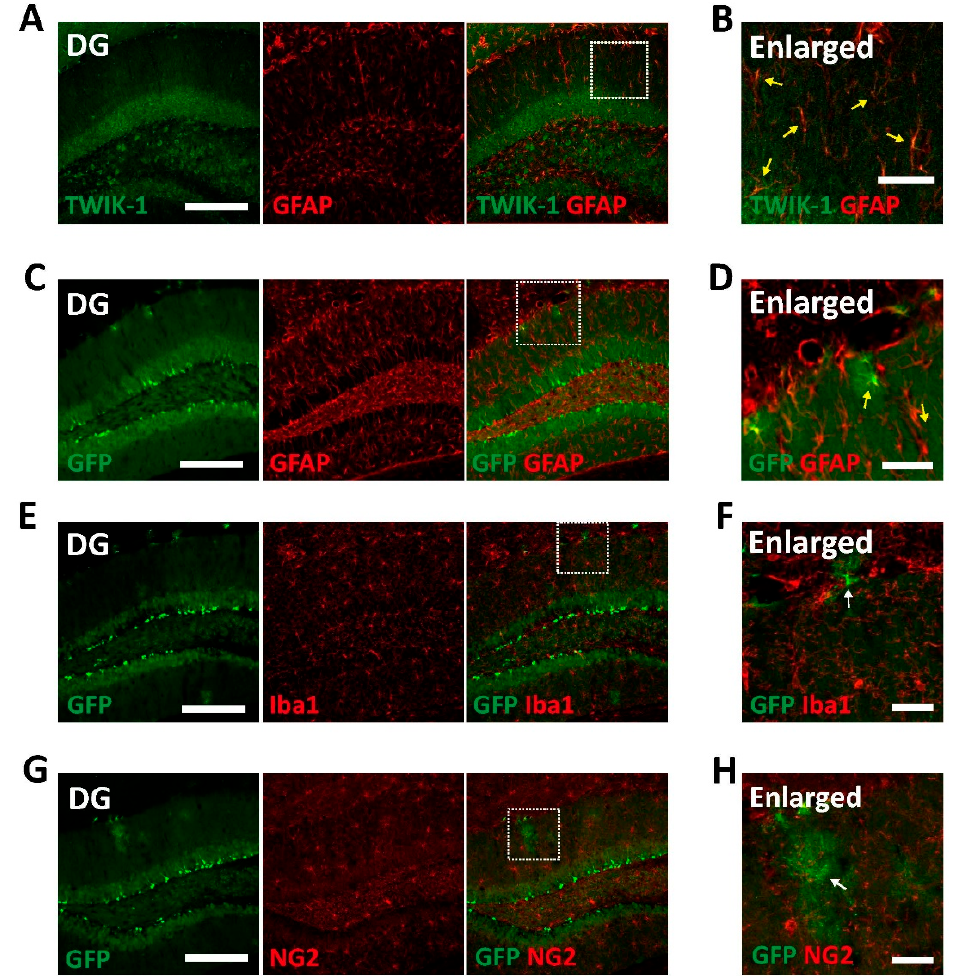
Figure 4. Glial expression of TWIK-1 in TWIK-1 BAC-GFP Tg mice. ( A ) Representative co-immunofluorescence images with TWIK-1 and GFAP. Scale bar, 200 μ m. ( B ) Enlarged inset from A. Yellow arrow indicates double immunoreactive cells with TWIK-1 and GFAP. Scale bar, 50 μ m. ( C ) Representative co-immunofluorescence images with GFP and GFAP. Scale bar, 200 μ m. ( D ) Enlarged inset from C. Yellow arrow indicates double immunoreactive cells with GFP and GFAP. Scale bar, 50 μ m. ( E ) Representative co-immunofluorescence images with GFP and Iba1. Scale bar, 200 μ m. ( F ) Enlarged inset from E. There are no Iba1-positive glial-like GFP-expressing cells (White arrow). Scale bar, 50 μ m. ( G ) Representative co-immunofluorescence images with GFP and NG2. Scale bar, 200 μ m. ( H ) Enlarged inset from G. There are no NG2-positive glial-like GFP-expressing cells (White arrow). Scale bar, 50 μ m.